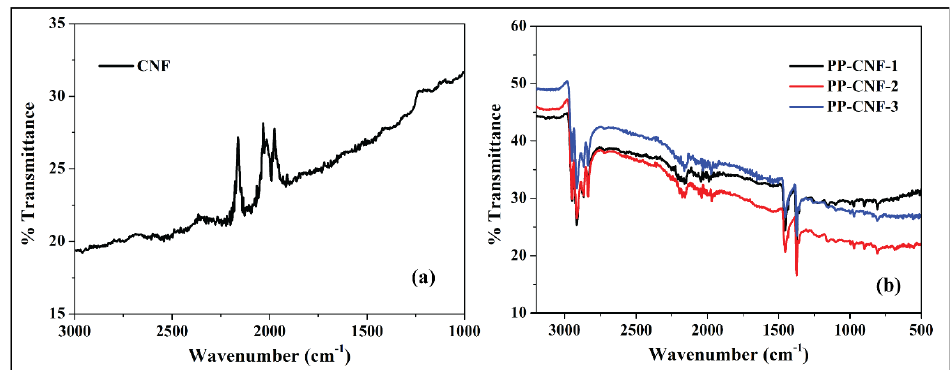
Figure 11. (a) FTIR spectra of CNF nanocomposites (b) FTIR spectra of PP-CNF nanocomposites. Figure 11. ( a ) FTIR spectra of CNF nanocomposites ( b ) FTIR spectra of PP-CNF